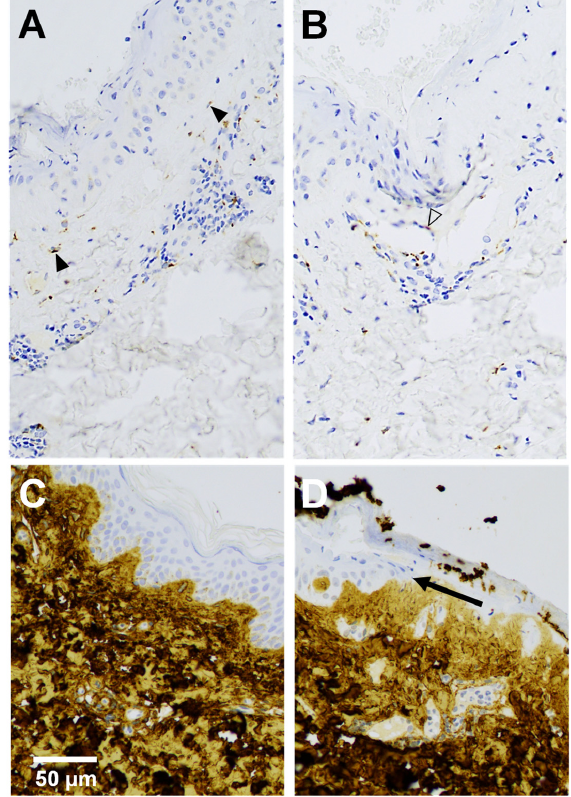
Figure 4. TIMP-1 ( A , B ) and collagen α 1 (I) ( C , D ) immunohistochemical analysis of a 4-day-old wound ( A , B , D ) with adjacent skin ( C ). ( A ) Fibroblasts (solid arrowheads) below neoepidermis and ( B ) endothelial cell (outline arrowhead) of small blood vessel show positive immunoreactivity of TIMP-1 in upper dermis. ( D ) Arrow indicates the tip of the migrating neoepidermal tongue. Collagen I strongly stained the dermis in both wounds and skin and was observed below the basement membrane but not in epidermis (Figure 4C,D).